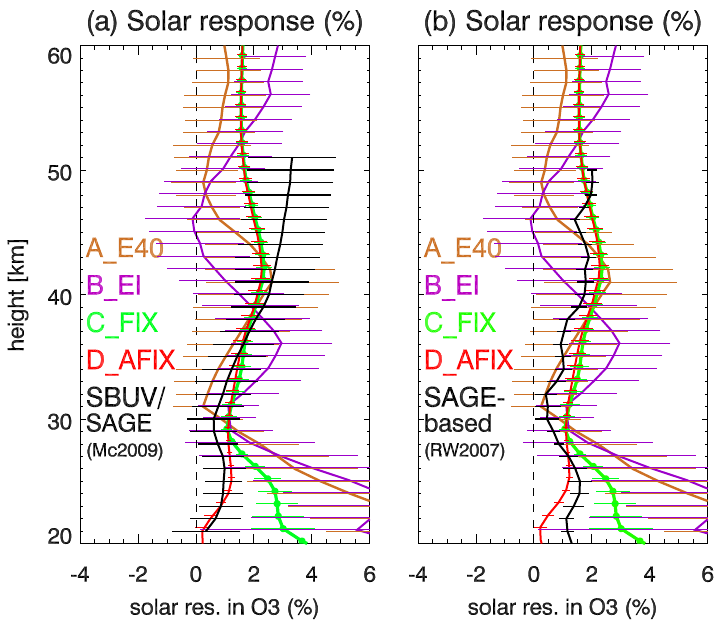
Fig. 6. Solar response in tropical (25 ◦ S–25 ◦ N) ozone (in %) estimated using regression analysis for model runs A E40 , B EI , C FIX and D AFIX compared with observations from (a) SBUV/SAGE (McLinden et al., 2009) and (b) SAGE-based (Randel and Wu, 2007) for 1979–2005. The error bars are 2 σ